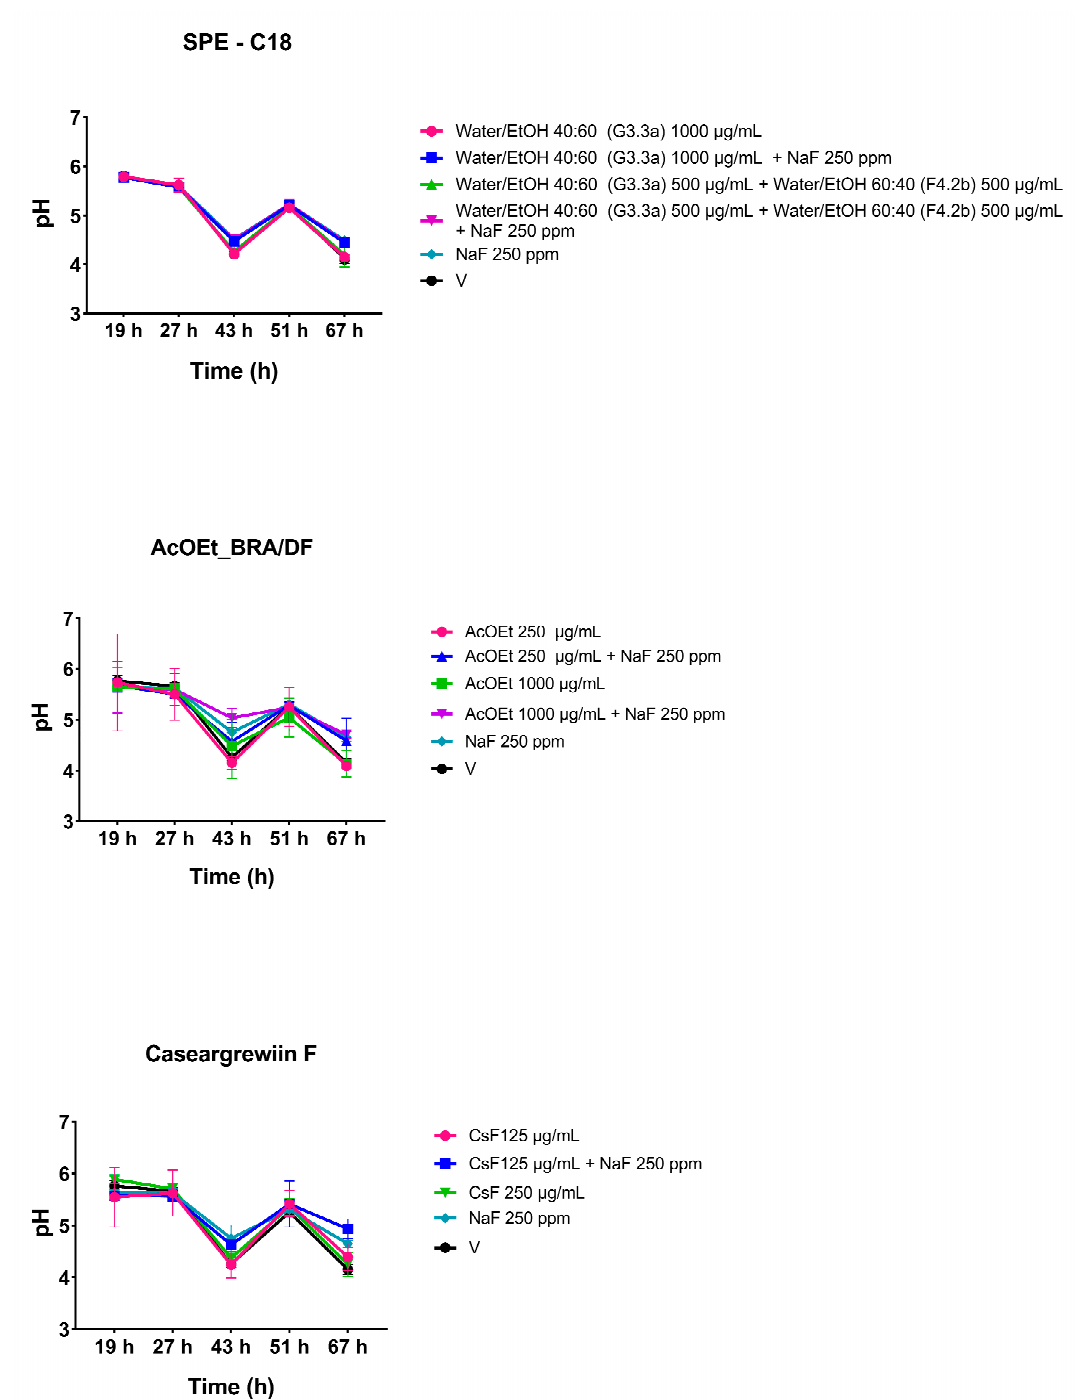
Figure 4. pH of spent culture medium from topically treated biofilms at different developmental stages. The spent biofilm culture media were analyzed at 19, 27, 43, 51, and 67 h. The central data are the mean, and the error bars are the confidence interval (95% CI). The vehicle control is represented as V (with the concentration being 10.52 % EtOH for the SPE-C18 fractions, 21.04% EtOH and 3.75% DMSO for the AcOEt_BRA/DF fractions, and 10.52% EtOH and 1.87% DMSO for CsF). The experiments for SPE-C18, AcOEt_BRA/DF, and CsF 125 µg/mL were performed in duplicate on one experimental occasion ( n = 1) and in duplicate on two separate occasions ( n = 2) for CsF 250 µg/mL.